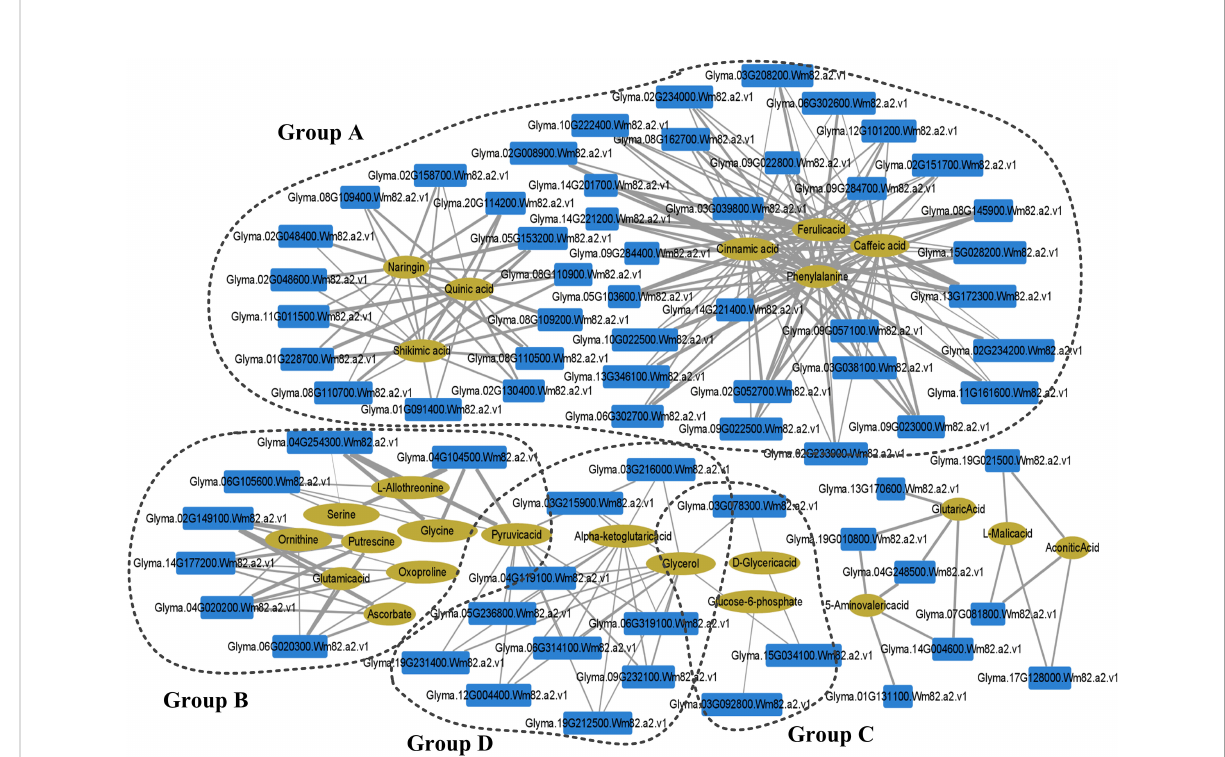
FIGURE 6 Integration network of metabolites and genes in barren-tolerant wild soybean seedling roots under phosphorus de fi ciency. The thicker the edge, the stronger the correlation. The size of a node is proportional to the correlation between nodes. Group A, closely related to secondary metabolism; Group B, related to remove ROS and protect the stability of cell membranes; Group C, related to membrane lipid remodeling and membrane phospholipid